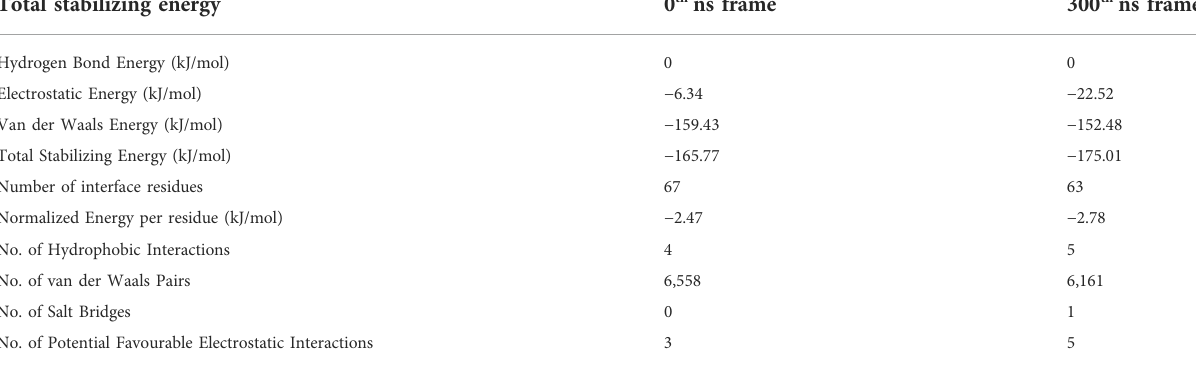
TABLE 2 The total stabilizing energy at t = 0 ns and t = 300 ns for the disease relevant Y10A mutant A β 1-42 fi bril (PDB ID: 2NAO) interacting with cyclotide Cter-M (PDB ID: